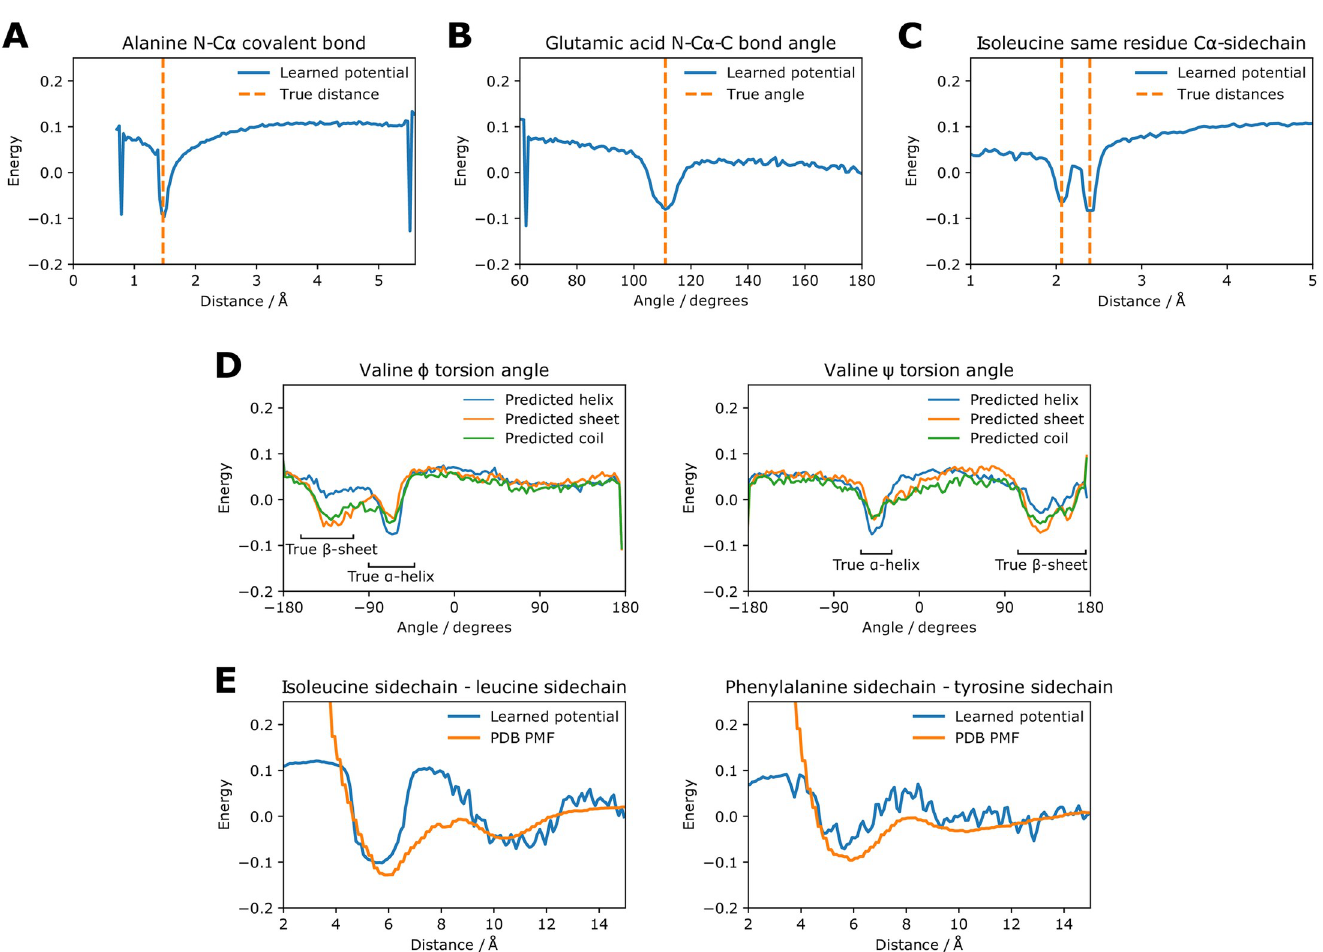
Fig 2. Components of the learned coarse-grained potential compared to true values. The energy scale is the same for each plot. Each individual potential consists of discrete energy values for 140 evenly-spaced bins. (A) Distance potential between N and C α in the same alanine residue, i.e. a covalent bond. (B) Bond angle potential for the N-C α -C angle in glutamic acid. (C) Distance potential between C α and the sidechain centroid on the same residue in isoleucine. (D) Torsion angle potentials in valine. There are different potentials for residues predicted as α -helical, β -sheet and coiled. The true ranges of α -helices and β -sheets are shown. (E) Distance potentials between sidechains for two pairs of amino acids. A PMF calculated from the PDB is also shown for comparison.